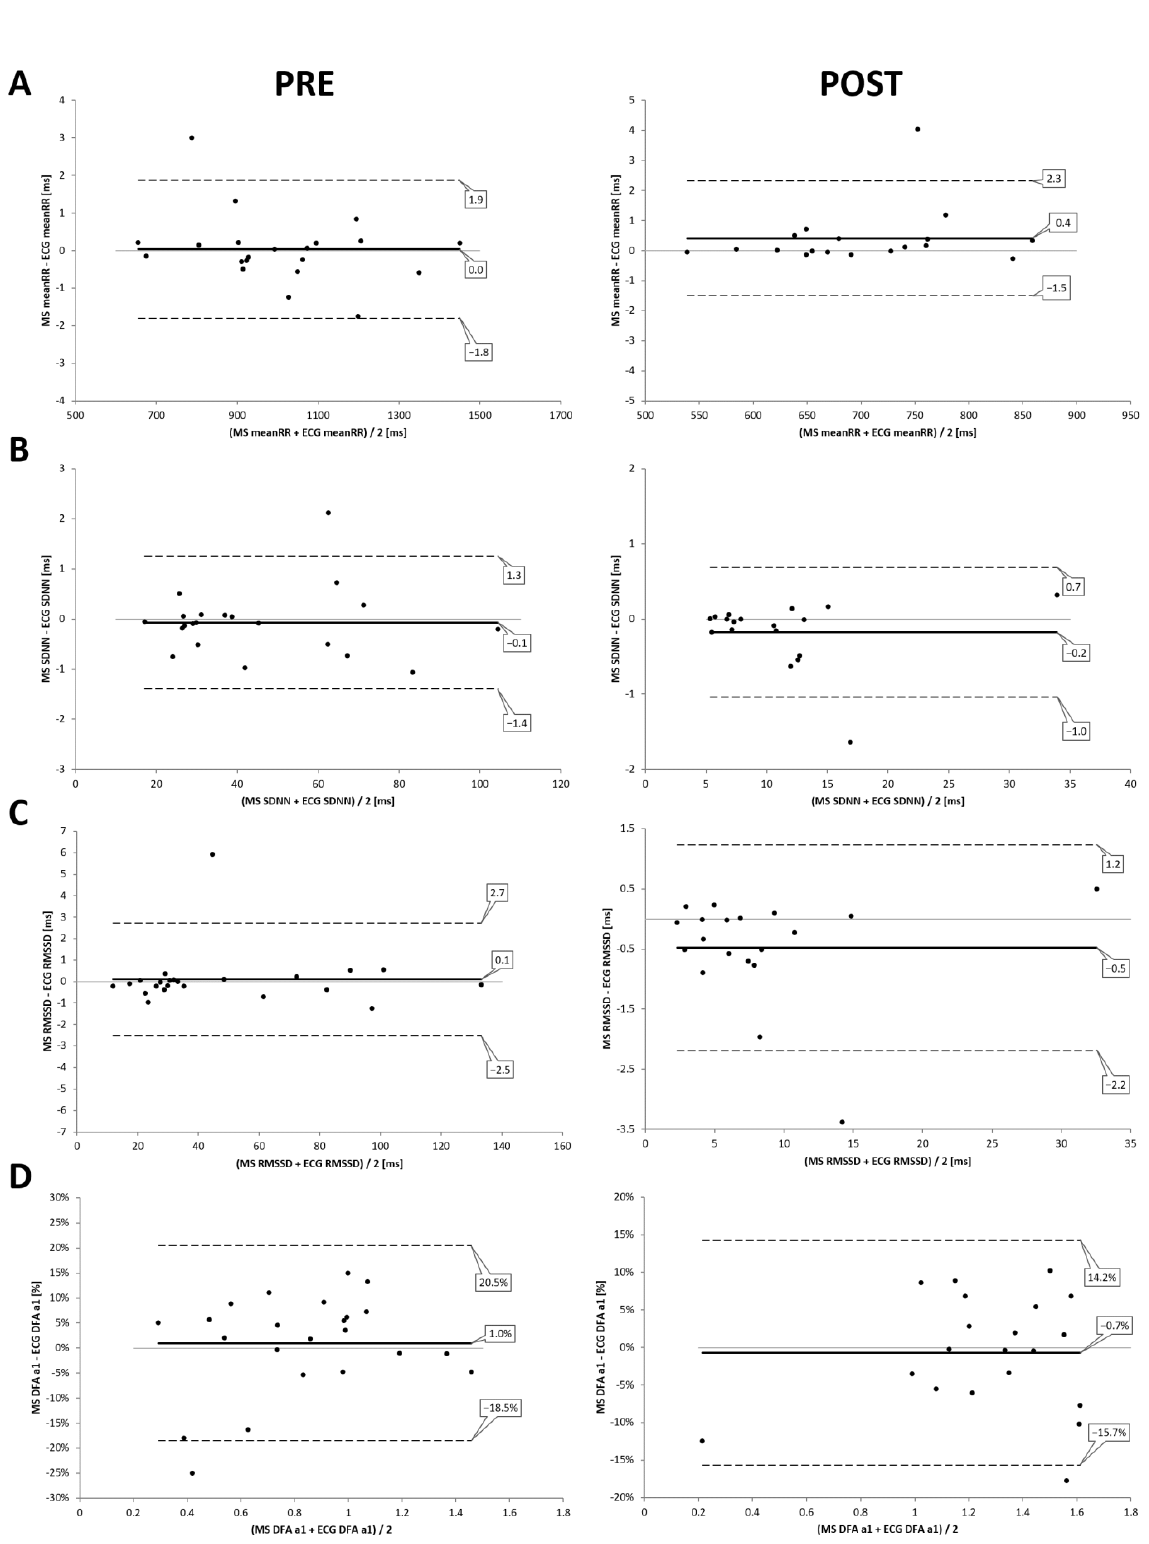
Figure 4. Bland–Altman analysis for the comparison of the 12 channel ECG (ECG) and the Movesense Medical sensor (MS) during PRE and POST the incremental exercise test for meanRR ( A ), SDNN ( B ), RMSSD ( C ), and DFA a1 ( D ). Center solid line in each plot represents the mean bias (difference) between each paired value as absolute time (ms) or relative differential (difference/mean × 100) in the case of DFA a1. The top and bottom dashed lines are 1.96 standard deviations from the mean